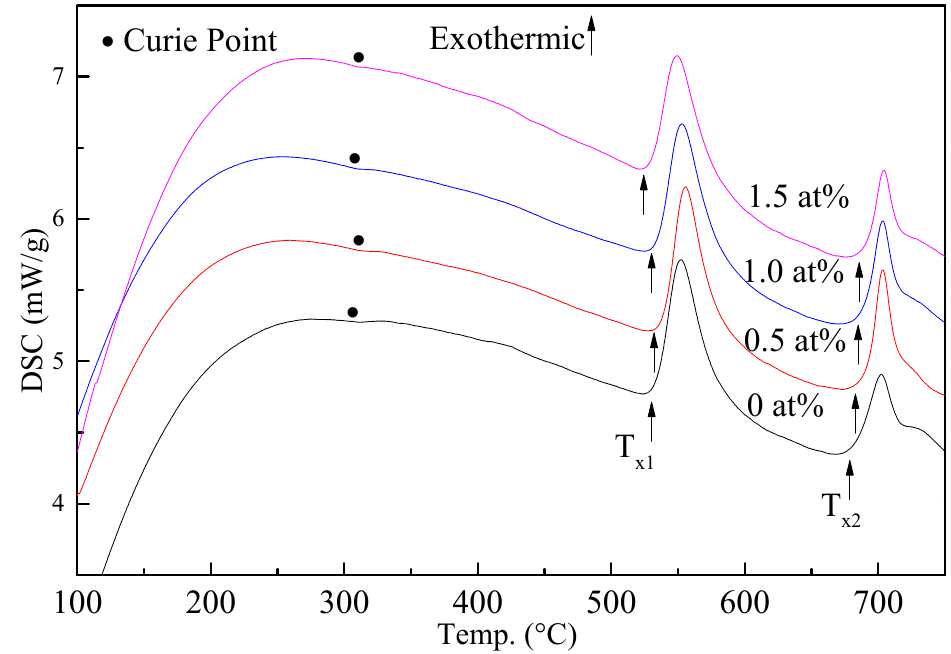
Figure 2. DSC data of as-cast alloys.